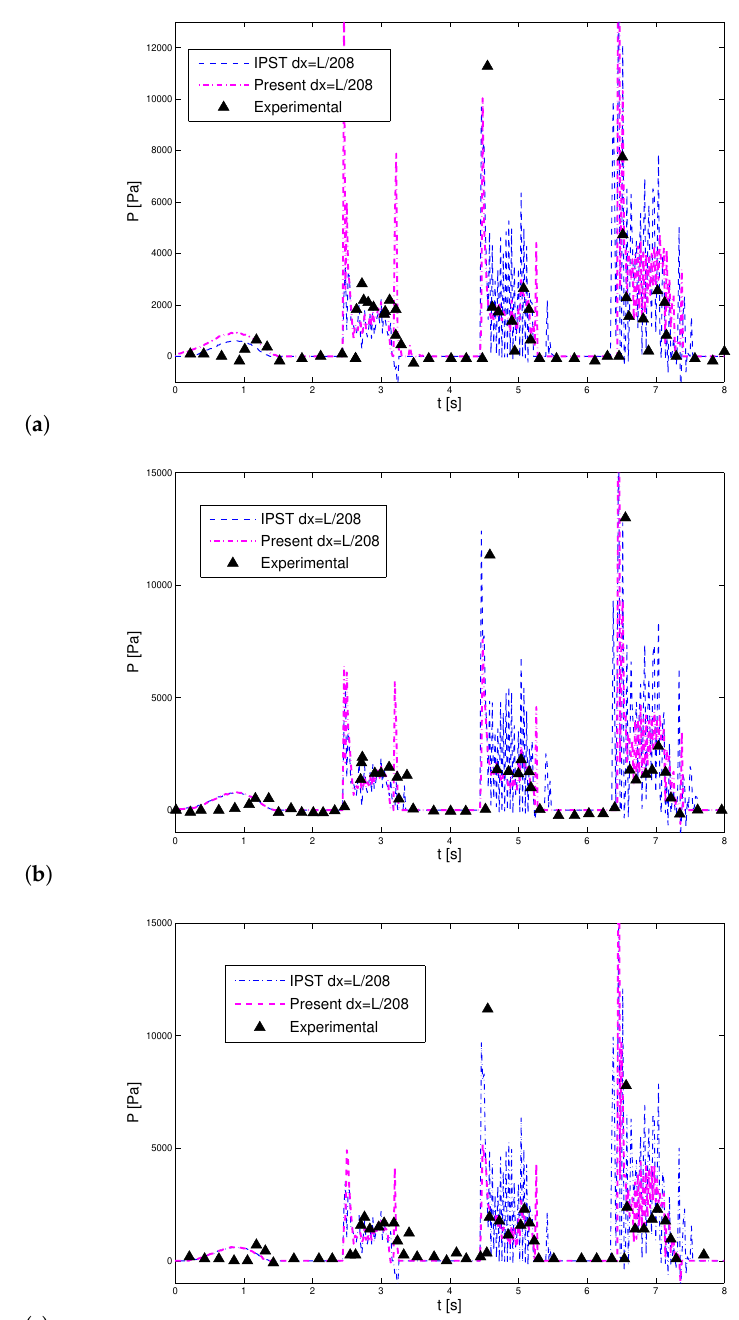
Figure 30. Sloshing in a rectangular tank: time history of the impact pressure at the three installed probes P 1 , P 2 and P 3 . figures ( a – c ) present the comparison between the present numerical and experimental pressure signals obtained at the probes P 1 , P 2 and P 3 , respectively. The black triangles denotes the experimental data given by Rafiee et al. [80]. The blue dashed line represents the results obtained by using IPST [37], whereas for the magenta dash-dot line presents the results obtained by the present particle shifting